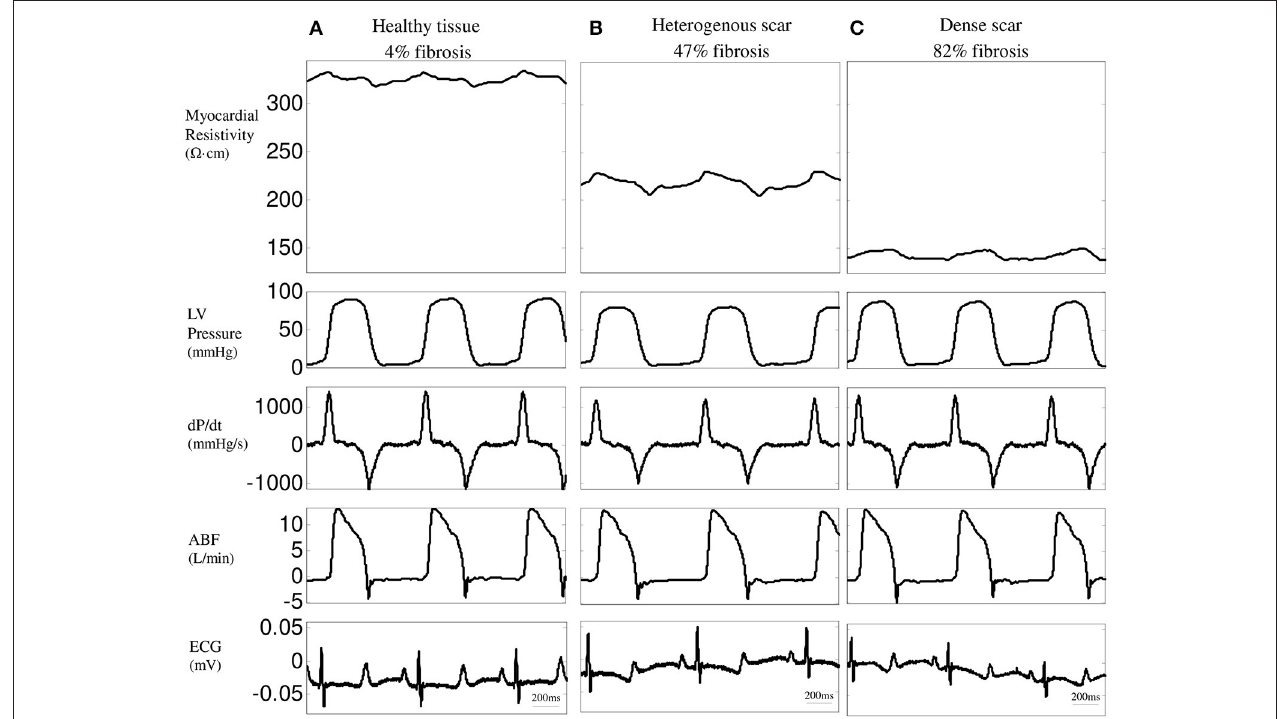
FIGURE 2 | Time-relationship between resistivity at 1kHz, left ventricular (LV) pressure, LV dP/dt, aortic blood flow (ABF), and ECG in three representative LV regions: healthy tissue (A), heterogeneous (B) and dense infarct scar (C).